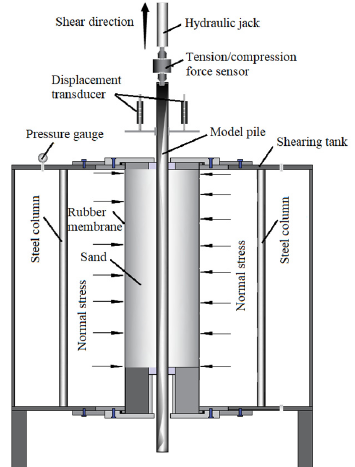
Figure 3. Schematic of the multifunctional interfacial shear instrument.